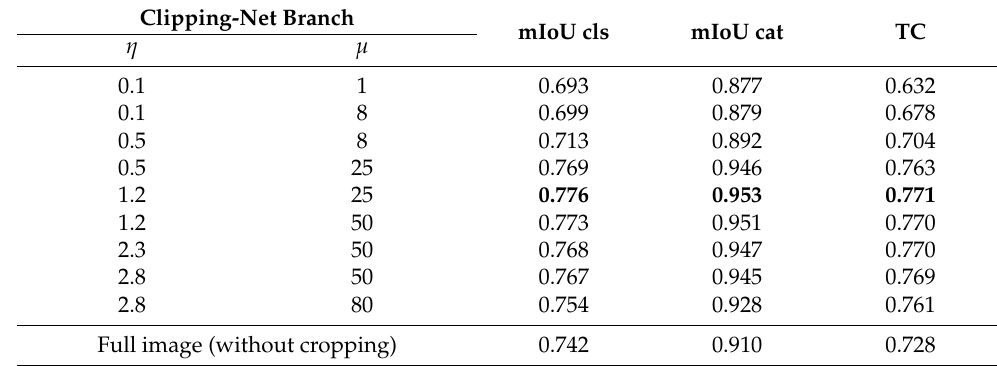
Table 2. The mIoU classes, mIoU categories, and TC of our model with dilation kernels of differ- ent sizes.